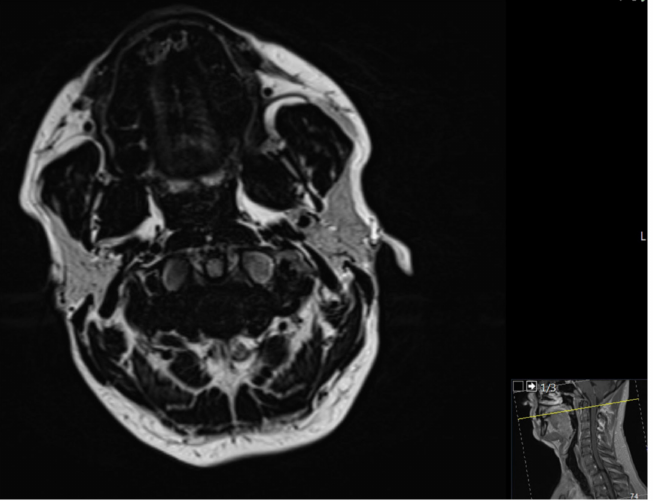
Figure 2. MRI (axial slices, T2)–tumor formation in the front region of the upper